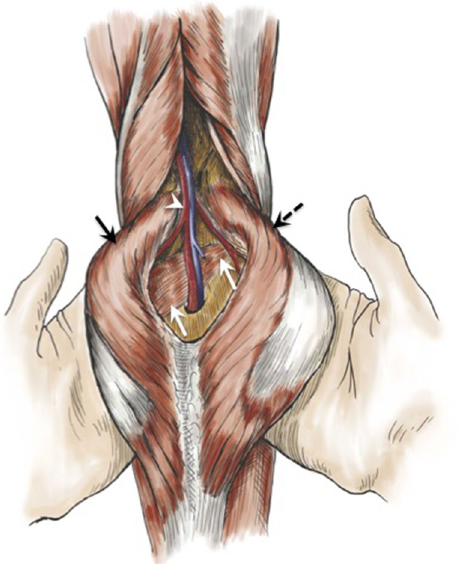
Fig. 1 Drawing showing normal anatomy of the popliteal artery. The popliteal artery ( white arrowhead ) is shown coursing through the popliteal fossa along with the popliteal vein, posterior to the popliteus muscle ( white arrows ) and between the femoral insertions of the medial ( black solid arrow ) and lateral ( black dashed arrow ) heads of the gastrocnemius